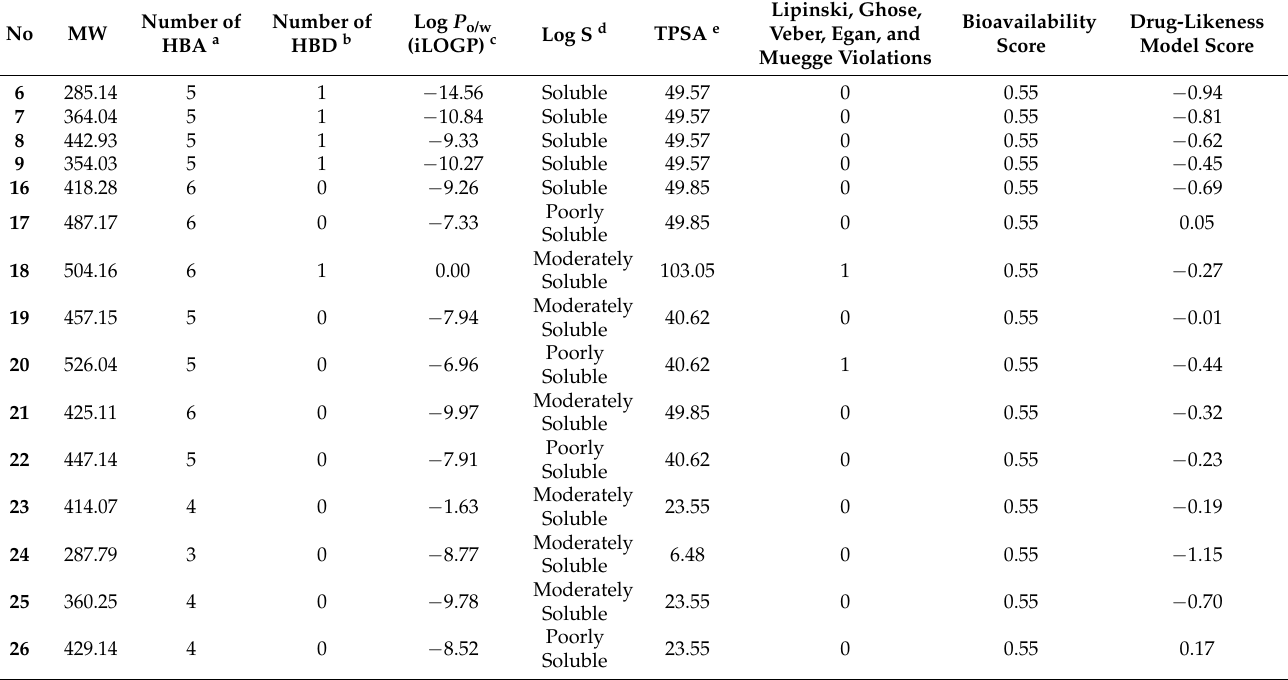
Table 4. Drug likeness predictions and physicochemical–pharmacokinetic/ADME properties of the tested